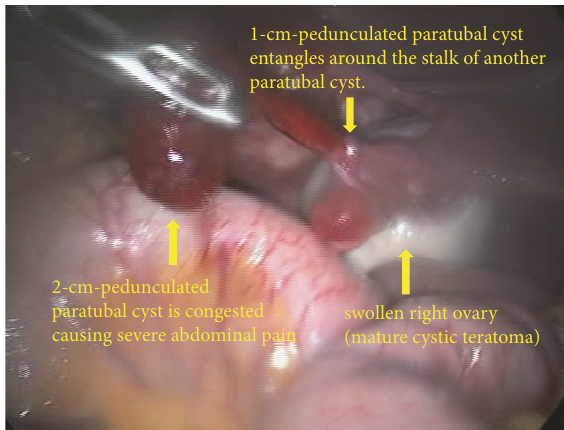
Figure 2: Intraoperative findings from laparoscopy.